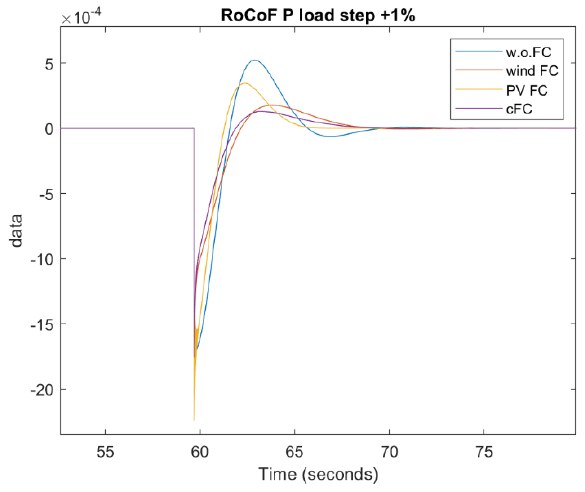
Figure 11 . Simulation 1 RoCoF. Figure 11. Simulation 1 RoCoF.